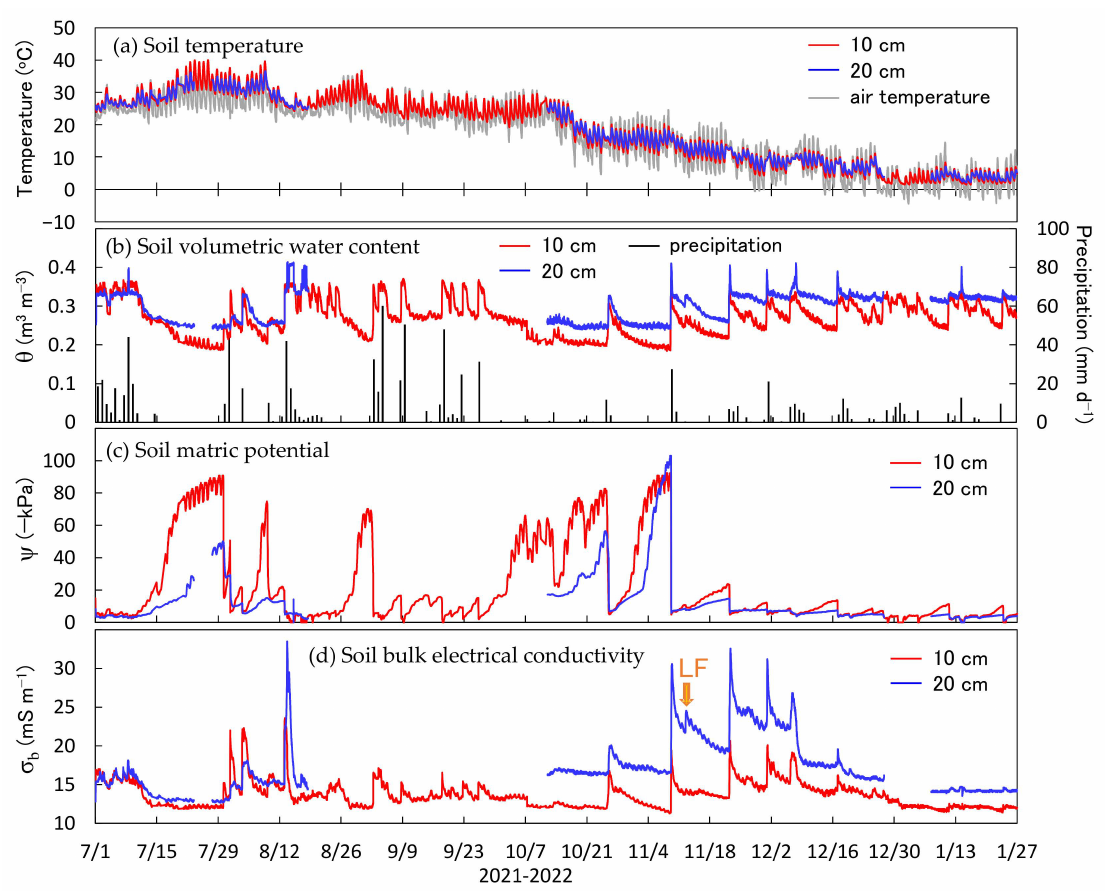
Figure 7. ( a ) Time series of soil properties measured with the new sensor in the Gifu University experimental field. The panels present ( a ) soil and air temperatures, ( b ) soil volumetric water content and precipitation, ( c ) soil matric potential, and ( d ) soil bulk electrical conductivity. The “LF” in panel ( d ) indicates liquid fertilizer